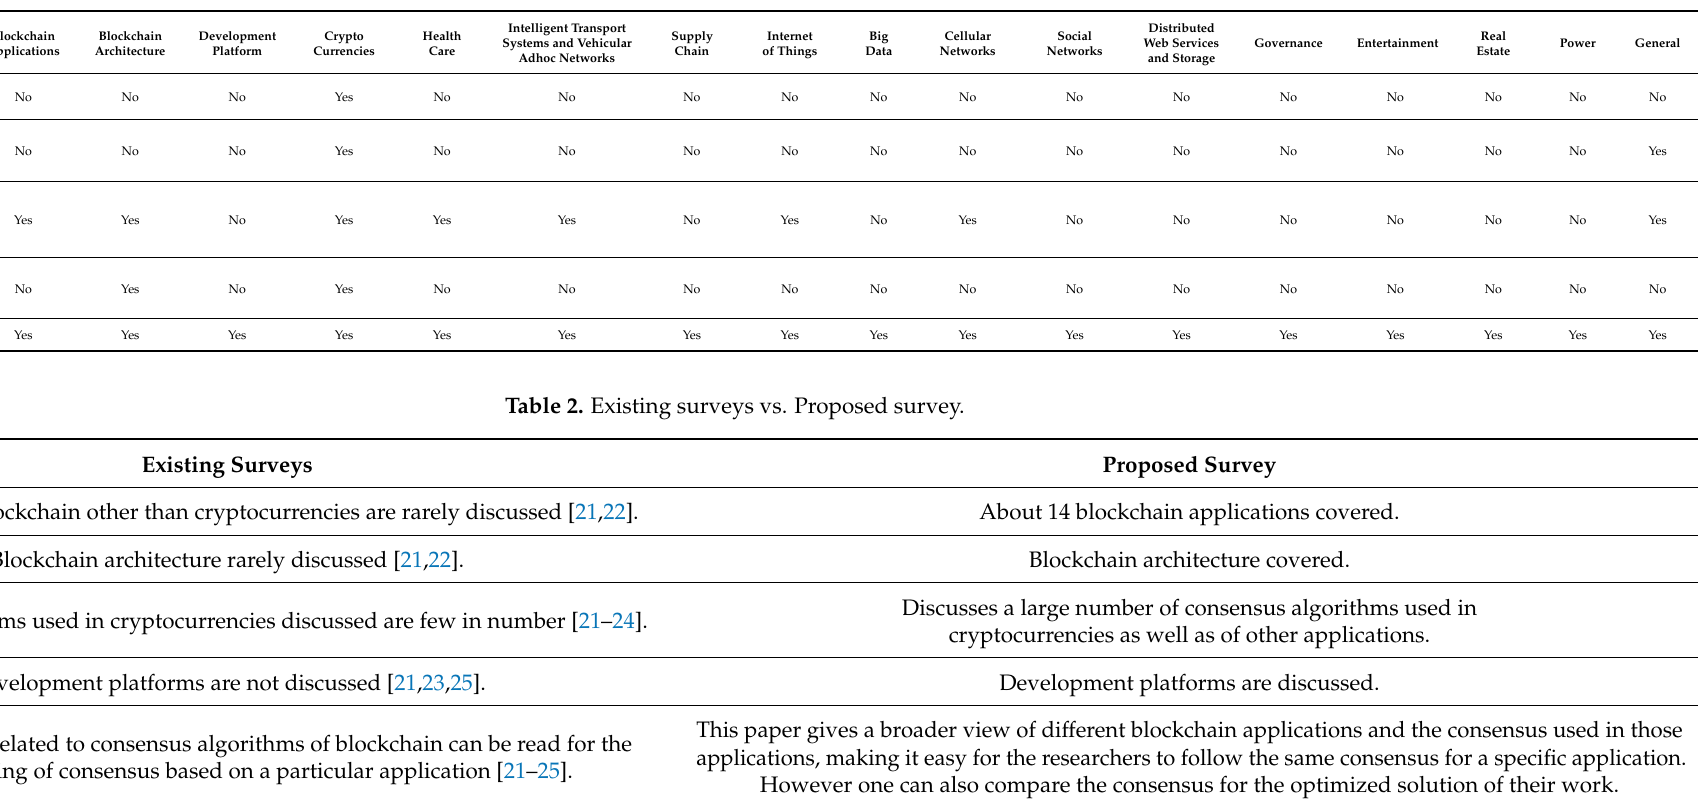
Table 1. Comparison of survey articles.